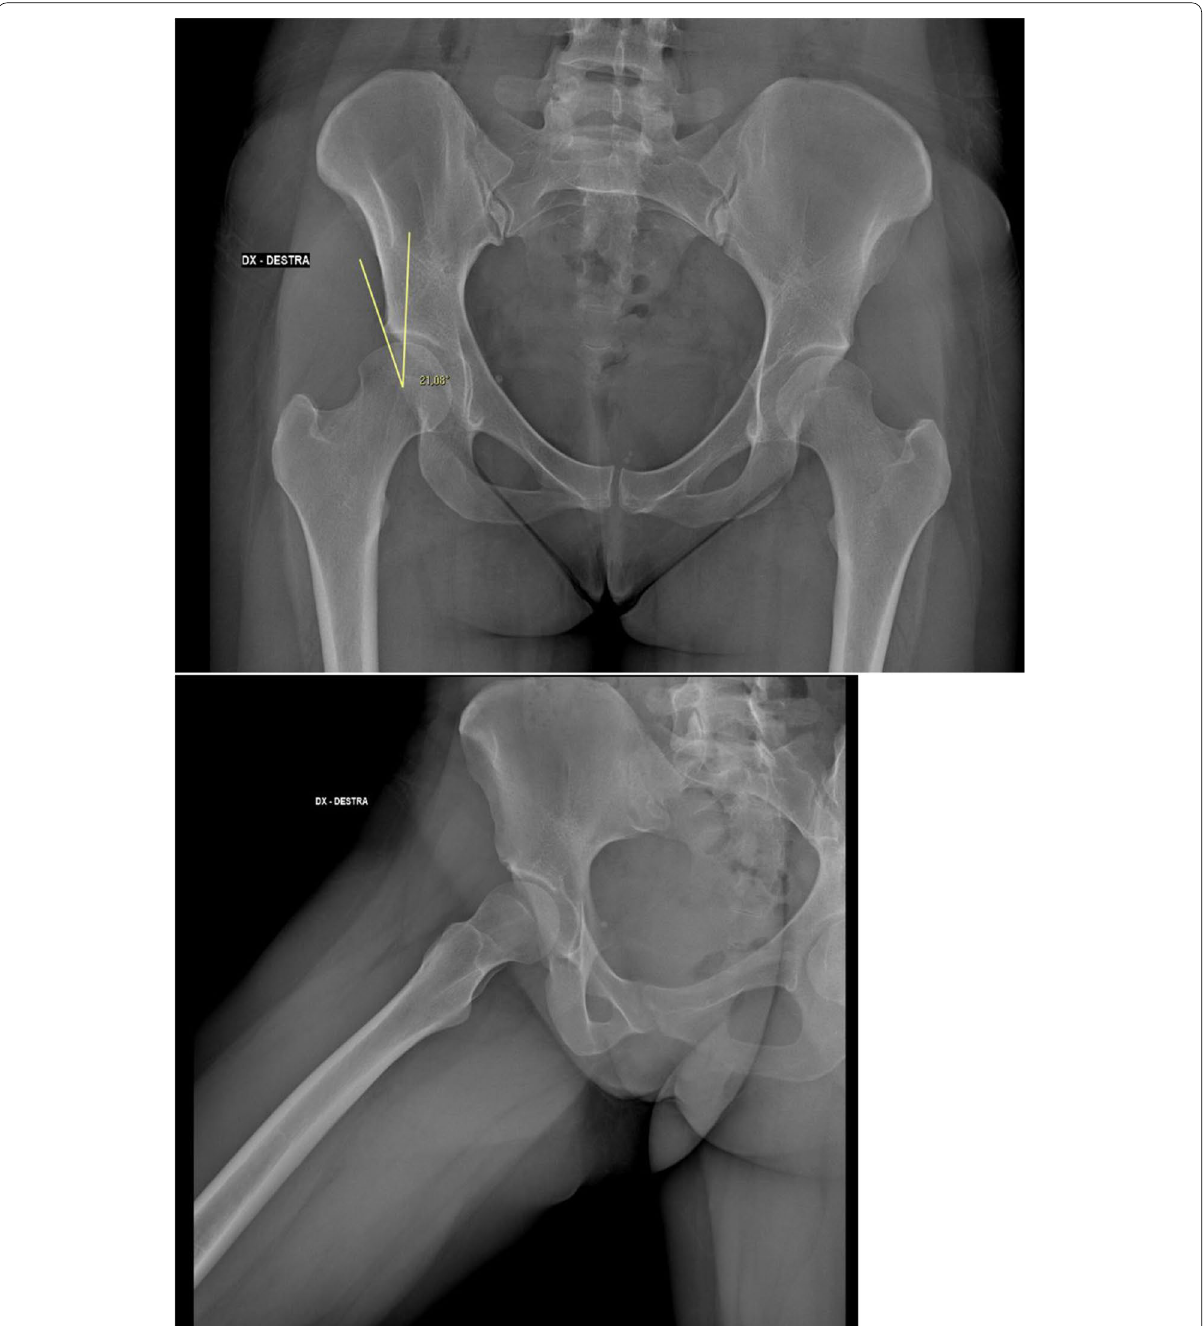
Fig. 1 Pre-operative X-Ray evaluation of a mild displastic patient: Anteroposterior of the pelvis and lateral Dunn 45° view radiographs of a 22 years old female included in group A (LCEA of 21.08°) with a CAM type impingement of the right